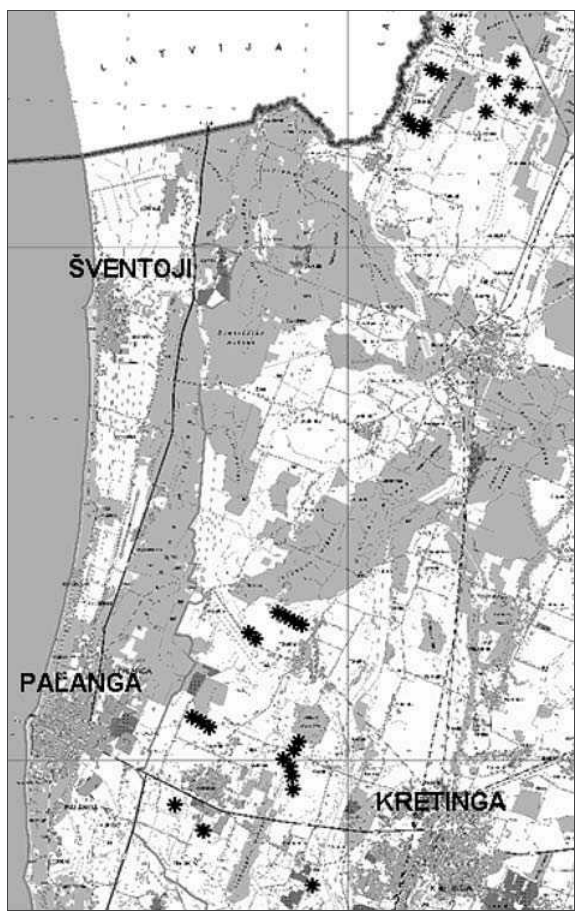
Fig. 3. Location of windpowerstation farms in kretinga district